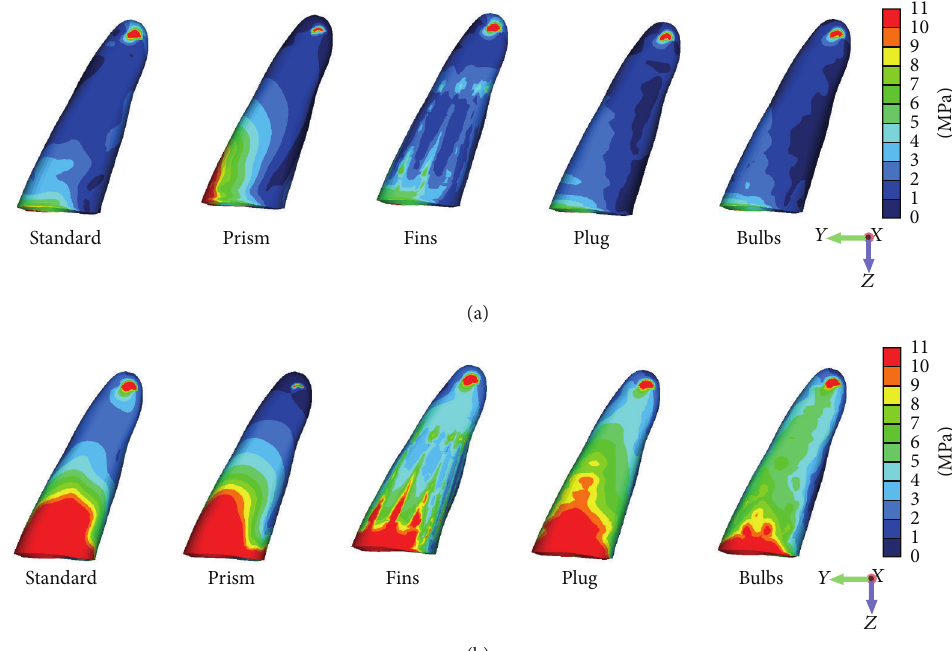
Figure 7: Distribution patterns of von Mises stress in the cortical outer layer of the surrounding bone under vertical (a) and oblique (b) loading components.